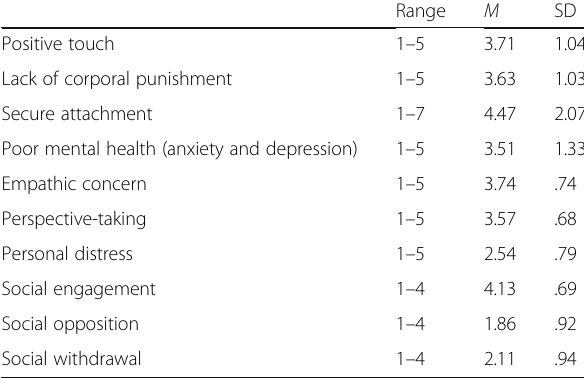
Table 4 Study 3 Means and standard deviations for touch reports and adulthood measures